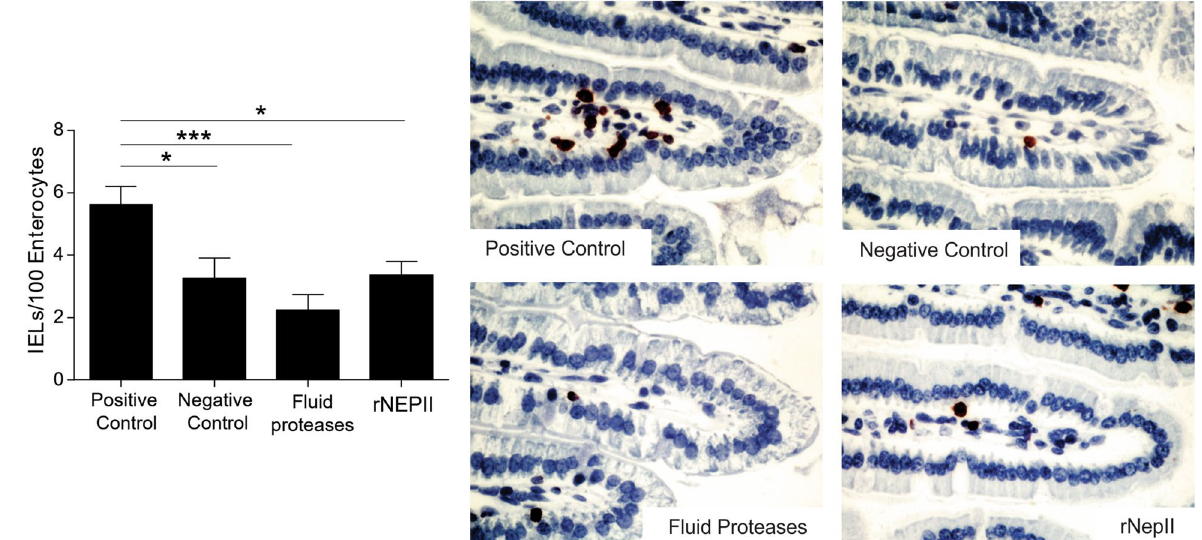
Figure 6. Nepenthes fluid protease treatment of gliadin prevents gliadin-induced inflammation in the NOD/ DQ8 transgenic mouse model of gluten-sensitivity. Intraepithelial lymphocyte (IEL) counts quantitated by immunostaining of proximal small intestine villi tips, in sensitized mice challenged with pepsin-treated gliadin (positive control), vehicle alone (negative control, gliadin-free diet), fluid protease-treated gliadin (1:264 ratio) and recombinant nepenthesin-II treated gliadin (1:100 ratio). Representative immunostained sections of intestinal tissues shown to the right at 40× magnification. Statistical significance (n = 8 for each state, * p < 0.05, *** p <